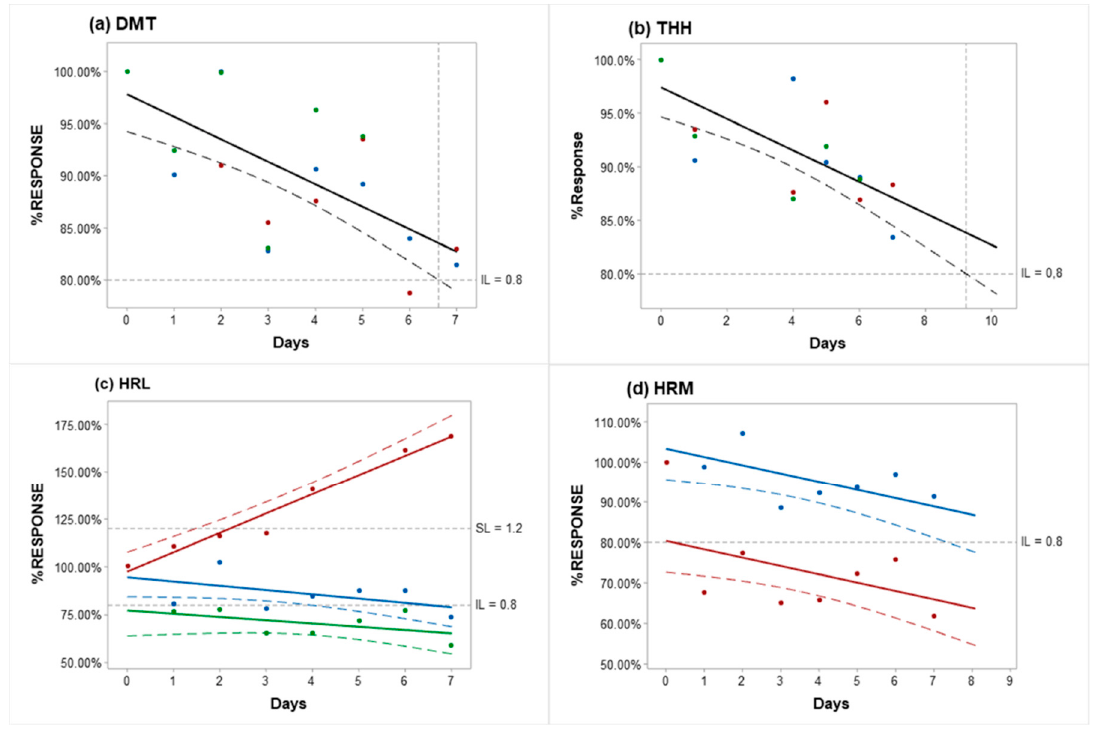
Figure 4. Graphs showing the stability profile over time for ( a ) DMT, ( b ) THH, ( c ) HRL, and ( d ) HRM after seven days of storage at 37°C. ● Sample T1, ● Sample T2, ● Sample T3. −−− Adjusted line. - - - - IL (inferior limit) or SL (superior limit). Confidence interval = 95%.